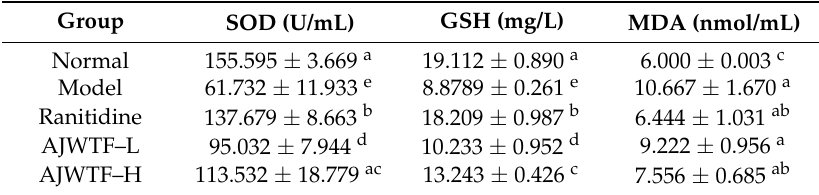
Table 4. Serum levels of superoxide dismutase (SOD), glutathione (GSH), and malondialdehyde (MDA) in mice from each group ( n =